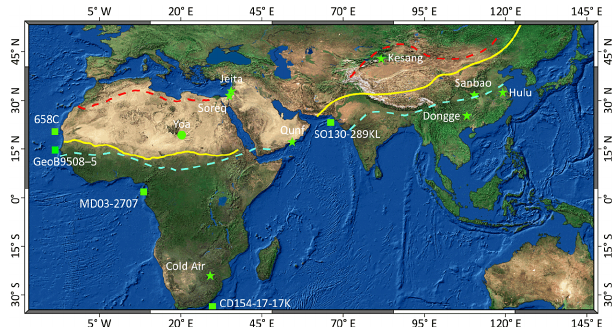
Figure 10. Location of selected monsoon records over the Holocene. Stars indicate locations of speleothem δ 18 O records (i.e., the Hulu, Dongge, Sanbao, Kesang, Qunf, Jeita Soreq and Cold Air records), squares show marine sediment records (i.e., the Hole 658C, GeoB9508-5, MD03-2707, SO130-289KL and CD154-17- 17K records), and the circle the Lake Yoa sediment record. See the Holocene record in the next section. The yellow line depicts approx- imately the modern summer monsoon fringe of Asian and North African monsoons. The red dashed line shows the estimated farmost North African (Adams, 1997) and Asian (Winkler and Wang, 1993; Jiang and Liu, 2007) summer monsoon fringe during the middle to early Holocene. The blue dashed line is the estimated Asian and North African monsoon fringe during the Last Glacial Maximum (Yan and Petit-Maire,